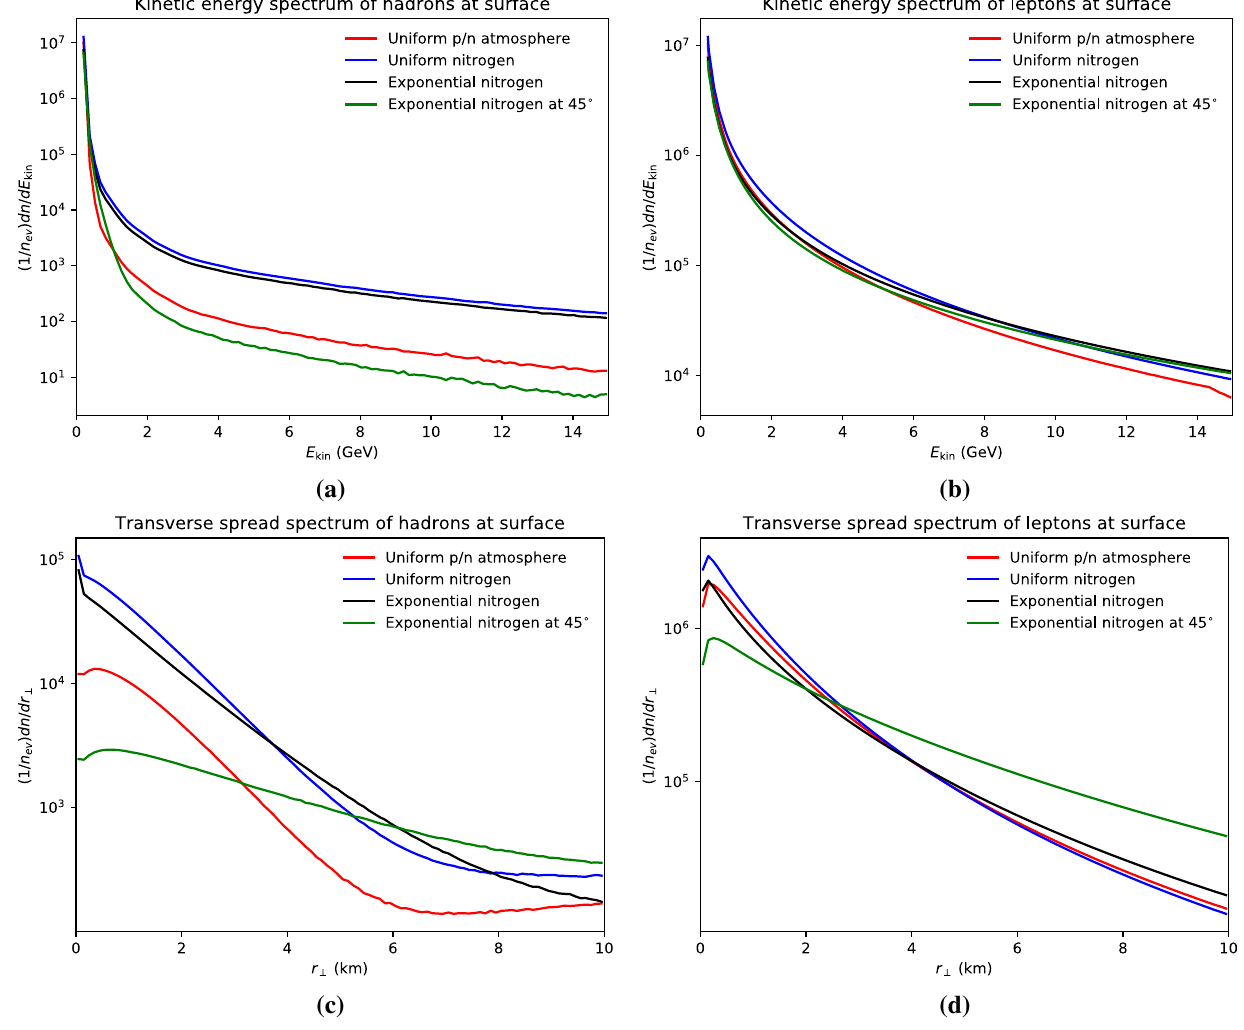
Fig. 14 Kinetic energy spectra (in a , b ) and transverse spread (in c , d ) of the particles that reach the surface for the same cascades as in Fig. 12. Shown are the spectra of a , c hadrons and b , d muons and